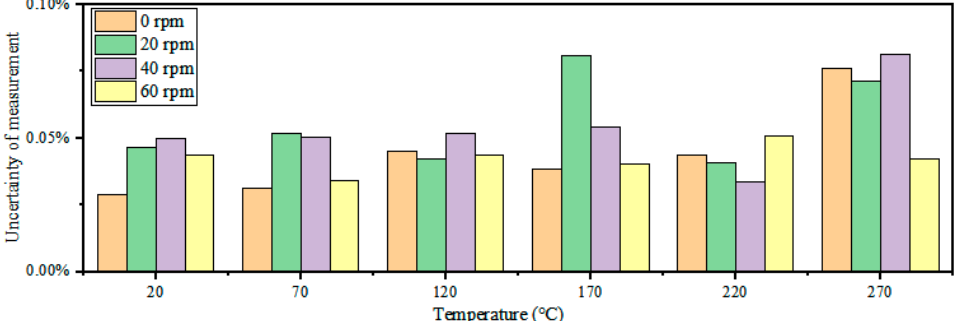
Figure 11. Uncertainty of the wireless LC conformal temperature sensor at different rotational speeds.